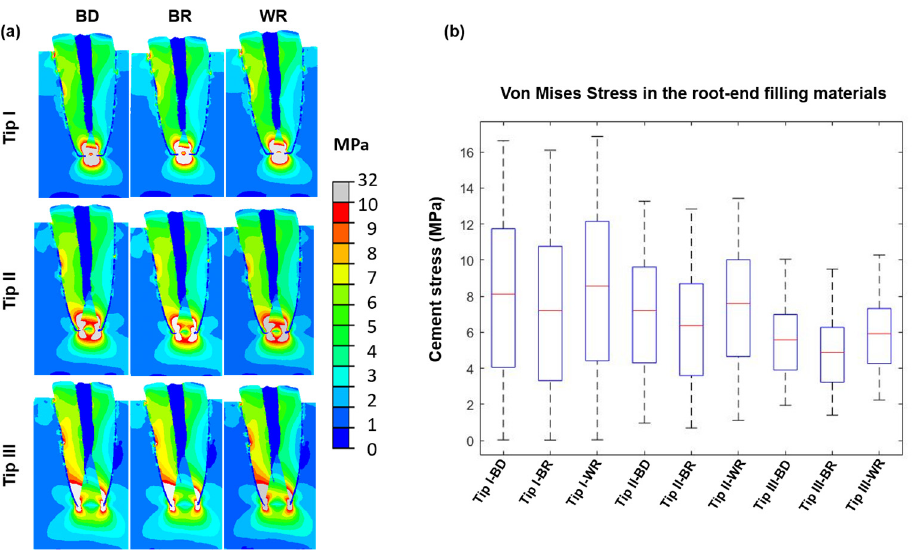
Figure 4. Biomechanical behavior of the resected root with ( a ) stress distribution and ( b ) boxplots presenting the cement stresses for different clinical situations with Biodentine™ (BD), MTA Biorep (BR), and Well-Root PT (WR) and apical diameter of 1 mm (Tip I), 1.4 mm (Tip II), and 1.8 mm (Tip III). On each box, the red central mark indicates the median, and the bottom and top edges of the box indicate the 25th and 75th percentiles, respectively.